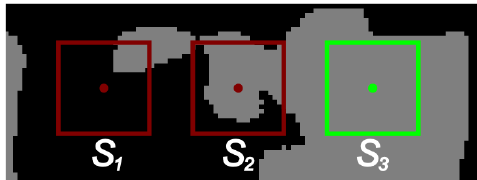
Figure 4: Training sample selection. Boxes S 1 − S 3 indicate N × N neighbourhood from feature extraction with center (dot). Class labels are depicted in grey, invalid area is black. S 1 and S 2 are not valid due to invalid center position and neighbourhood, respectively. Only S 3 is a valid sample.